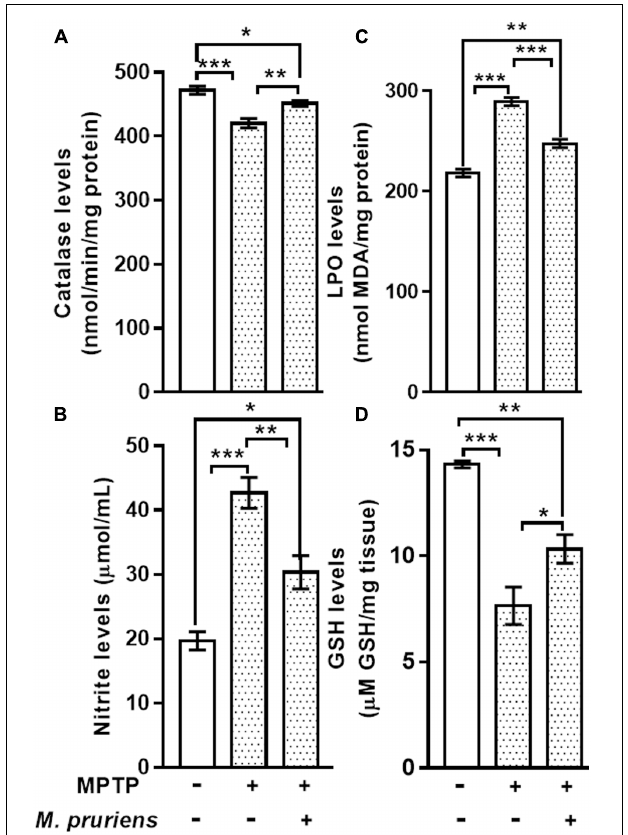
FIGURE 3 | Estimation of CAT, Nitrite, MDA, and GSH in nigrostriatal region of mice. MPTP injected mice showed significant decrease in CAT activity and GSH level and increase in Nitrite and MDA level as compared to control (CONT) group. While Mp treatment in MPTP group significantly increase the level of CAT (A) , decrease in the level of nitrite (B) and MDA (C) , increase in the level of GSH (D) . Values are expressed as mean ± SEM ( ∗ p < 0.05, ∗∗ p < 0.01, ∗∗∗ p < 0.001, n = 3). ns, non-significant; MDA, malondialdehyde; GSH, glutathione; CAT, catalase; SEM, standard error of